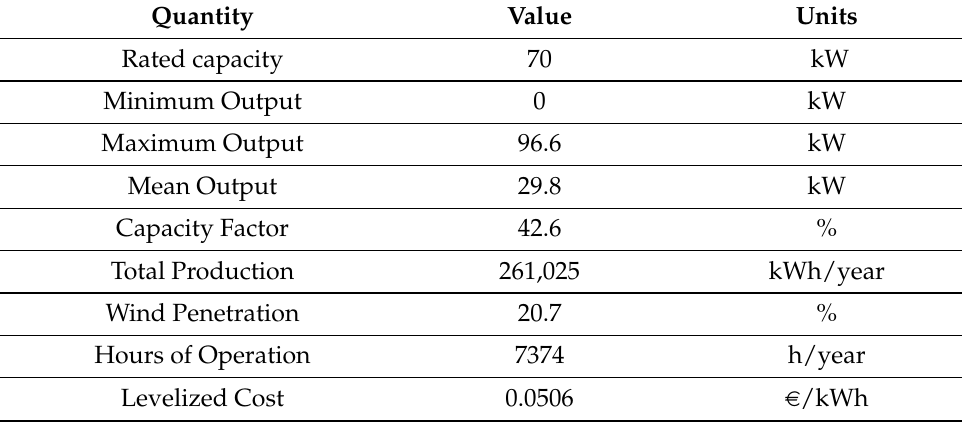
Table 25. Aeolos-H (10 kW) Scheme Simulation Results Case 1 Scenario